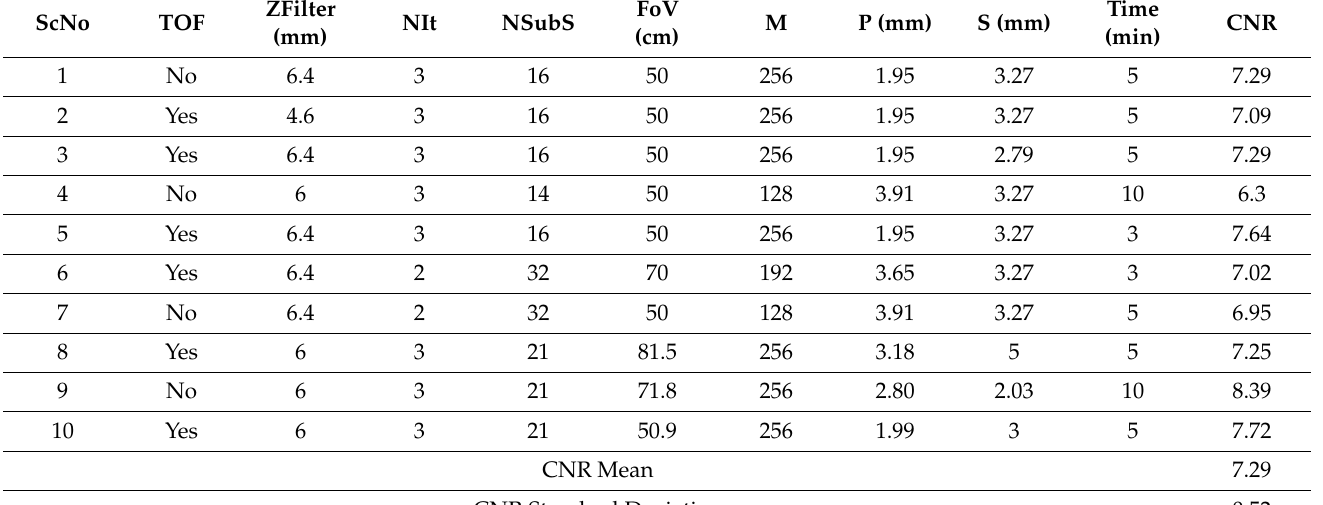
Table 5. Reconstruction parameters and contrast-to-noise ratios for the harmonized dataset (10 PET images). ScNo = scanner number according to Table 1. TOF = time of flight scanner, ZFilter = post- reconstruction Zfilter, NIt = number of iterations, NSubS = number of subsets, FOV = field of view, M = matrix size, P = pixel spacing (pixel size), S = slice thickness, Time = acquisition time (per bed position), CNR = contrast-to-noise ratio according to Equation